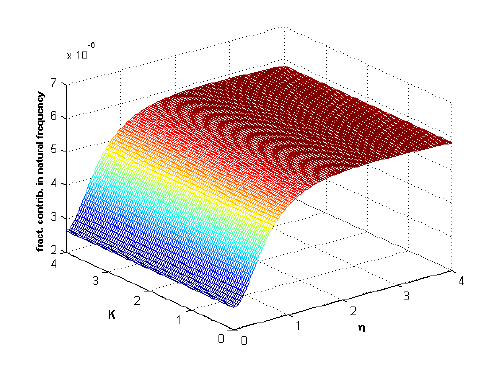
Figure 11. Fractional contribution frequency versus stiffness K and nonlocality η ( α =